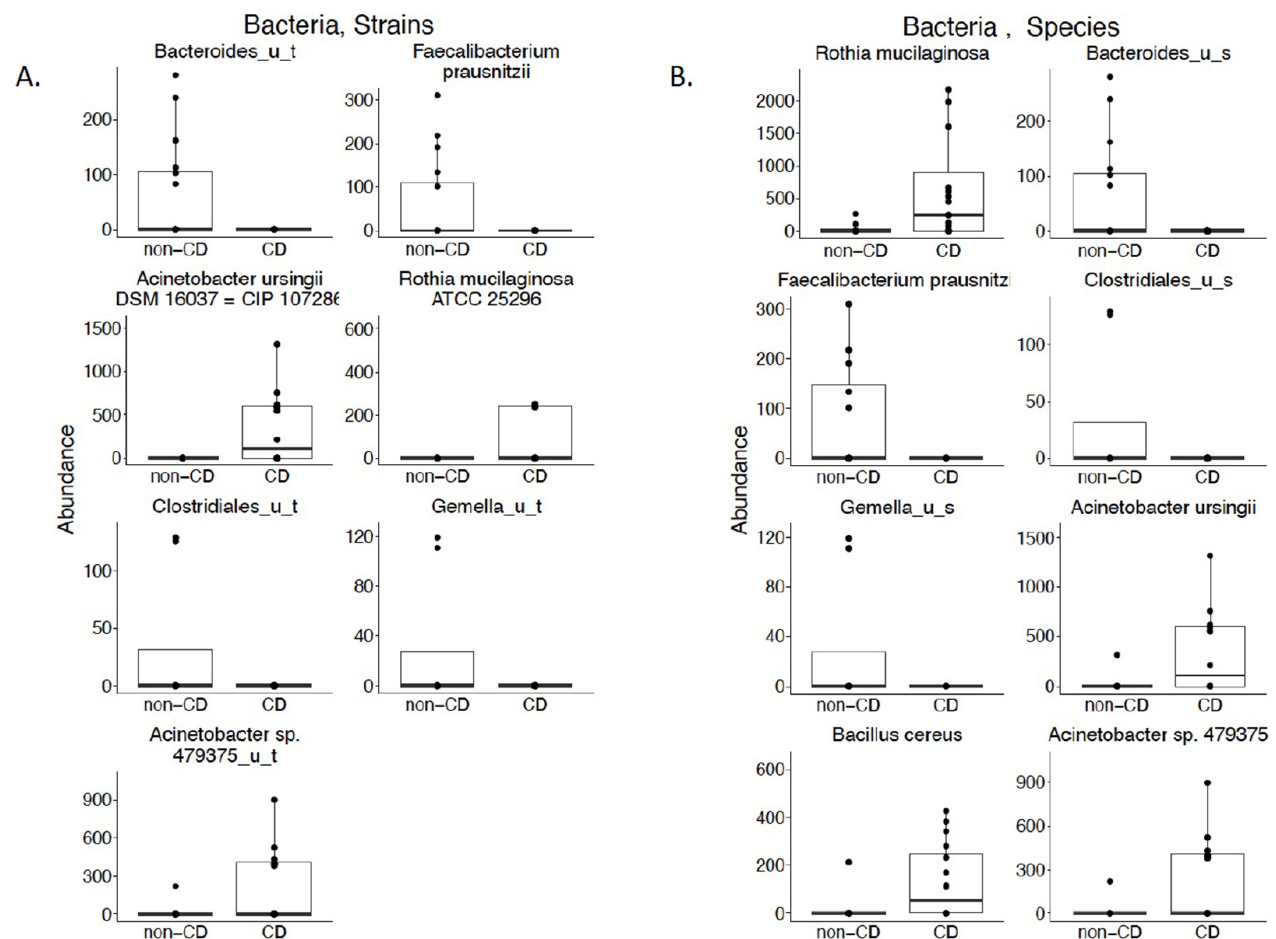
Figure 1. ( A ) Cross-sectional analysis of bacterial strains in the breast milk of subjects with CD on a gluten-free diet compared with healthy controls. Bacterial strains with a statistically significant difference in abundance between the breast milk of subjects with CD on a gluten-free diet and healthy controls according to Mann–Whitney U test (Wilcoxon rank-sum test) ( p -value < 0.05). ( B ) Cross-sectional analysis of bacterial species in the breast milk of subjects with CD on a gluten-free diet compared with healthy controls. Bacterial species with a statistically significant difference in abundance between the breast milk of subjects with CD on a gluten-free diet and healthy controls according to Mann–Whitney U test (Wilcoxon rank-sum test) ( p -value < 0.05).